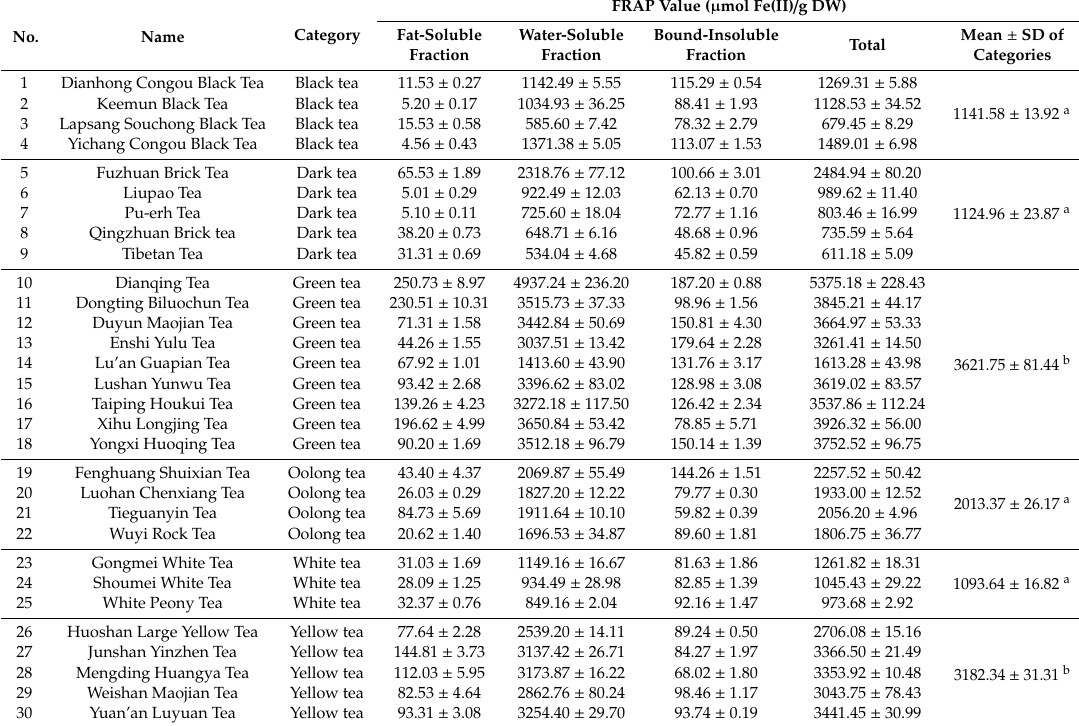
Table 2. Ferric-reducing antioxidant power (FRAP) values of the 30 common Chinese teas.